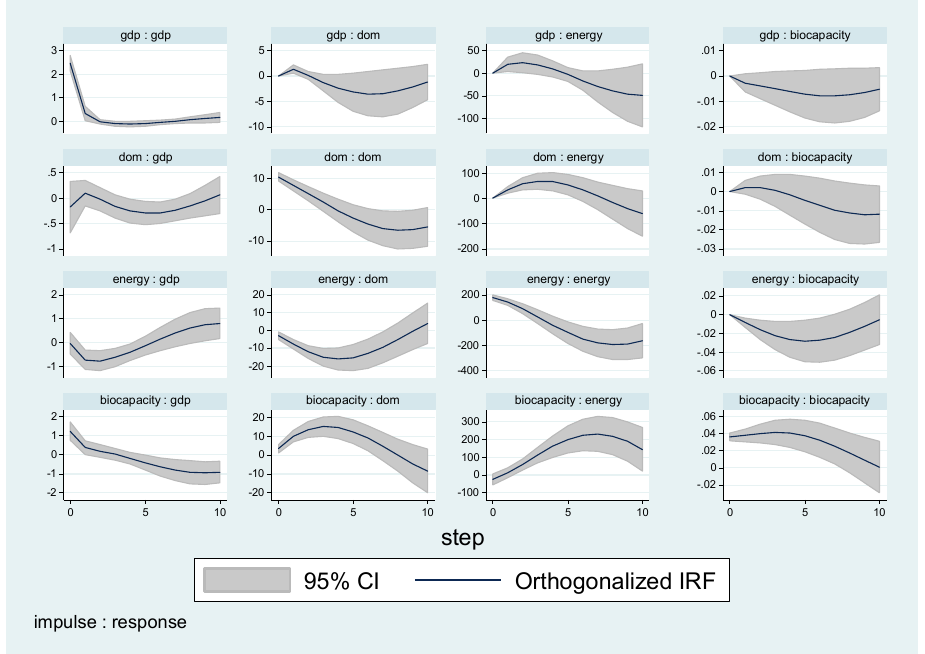
Figure 2. Impulse response function (IRF) test results of biocapacity, energy consumption, domestic money, and GDP.